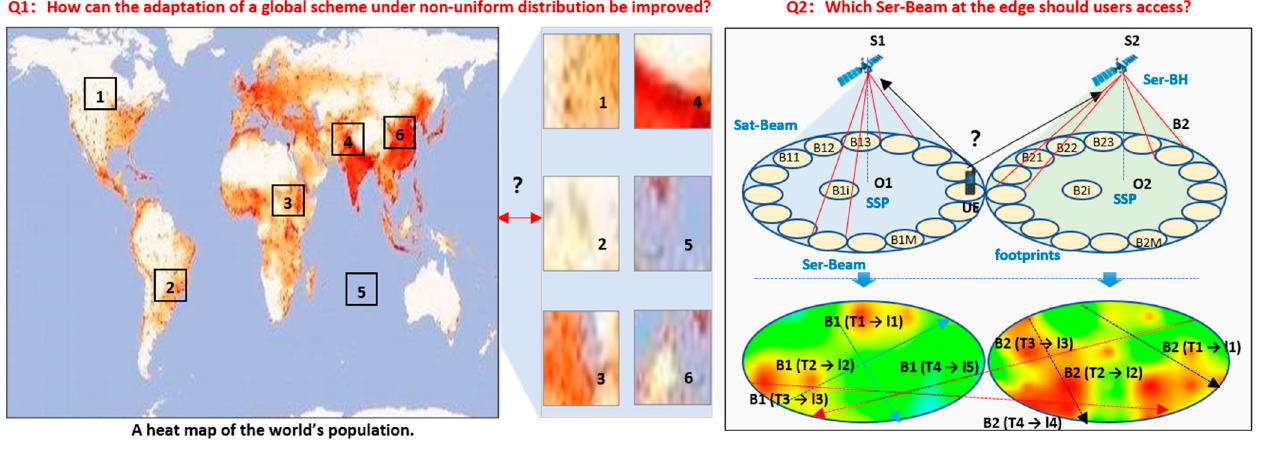
Figure 1. The problems of load balancing for Ser-BH in SIN.